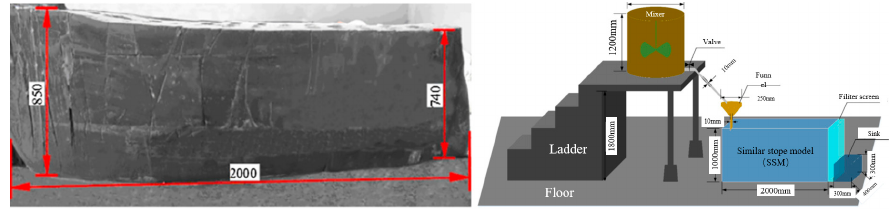
Figure 9. Simulated stope backfilling massif.